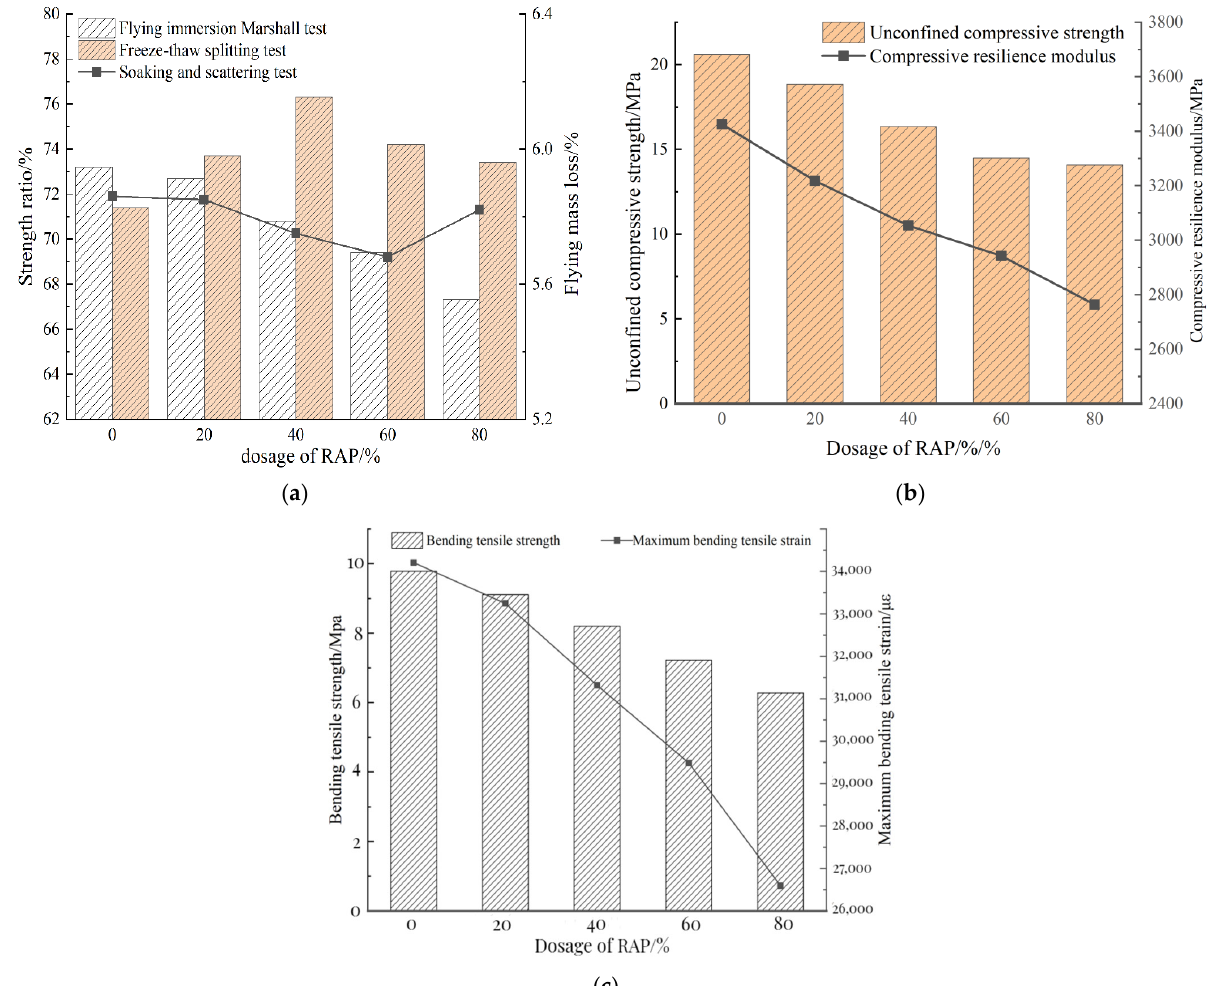
Figure 9. The in fl uence of RAP content on three kinds of road performance. ( a ) E ff ect of RAP content on water stability. ( b ) Relationship diagram between uniaxial compression test results and RAP dosage. ( c ) Relationship between fl exural strength and maximum fl exural strain of PRCM and RAP dosage.